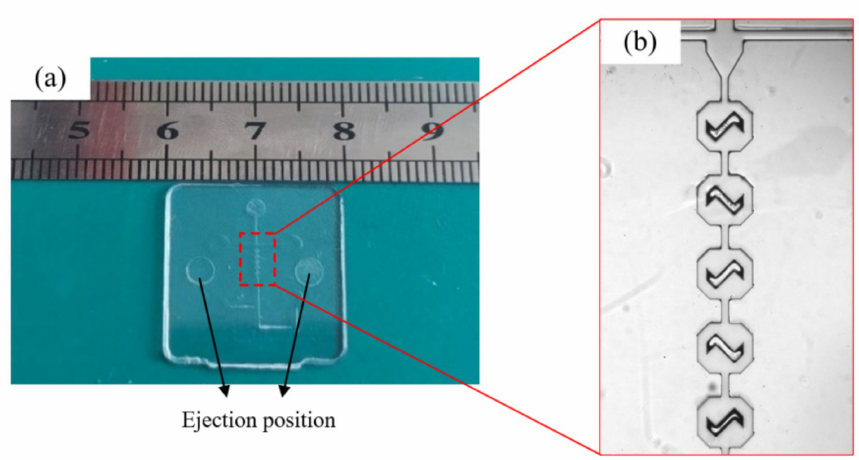
Figure 4. An injection molded product: ( a ) PC microfluidic chip, ( b ) micro-mixing zone observed with light